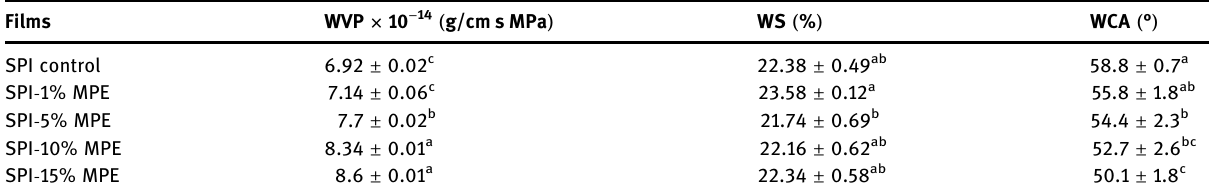
Table 5: WVP, WS, and WCA of SPI fi lms as a ff ected by MPE incorporation